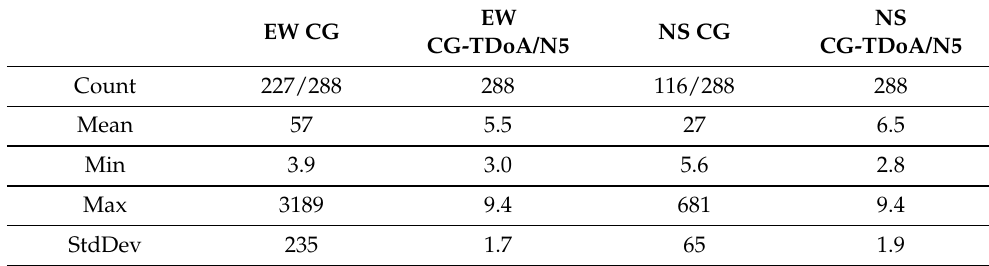
Table 5. Urban canyon (24-m-high buildings) scenarios: statistical analysis of the PDOP for GNSS- alone (CG) and GNSS + TDoA from five 5G base stations (CG-TDoA/N5). EW = east-west street; NS = north-south street.